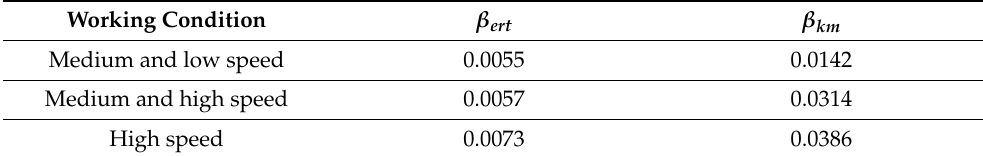
Table 4. The root mean square error of three